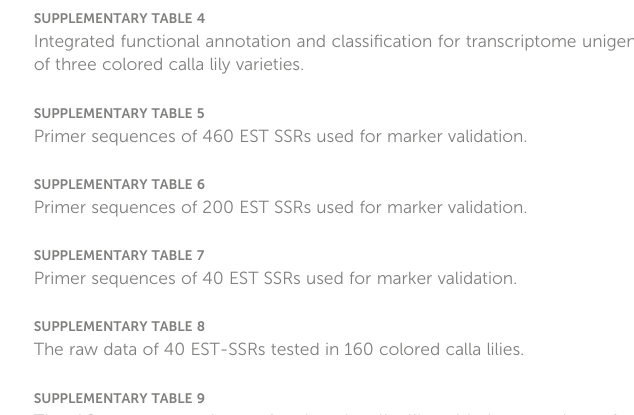
SUPPLEMENTARY TABLE 6 Primer sequences of 200 EST SSRs used for marker validation. SUPPLEMENTARY TABLE 7 Primer sequences of 40 EST SSRs used for marker